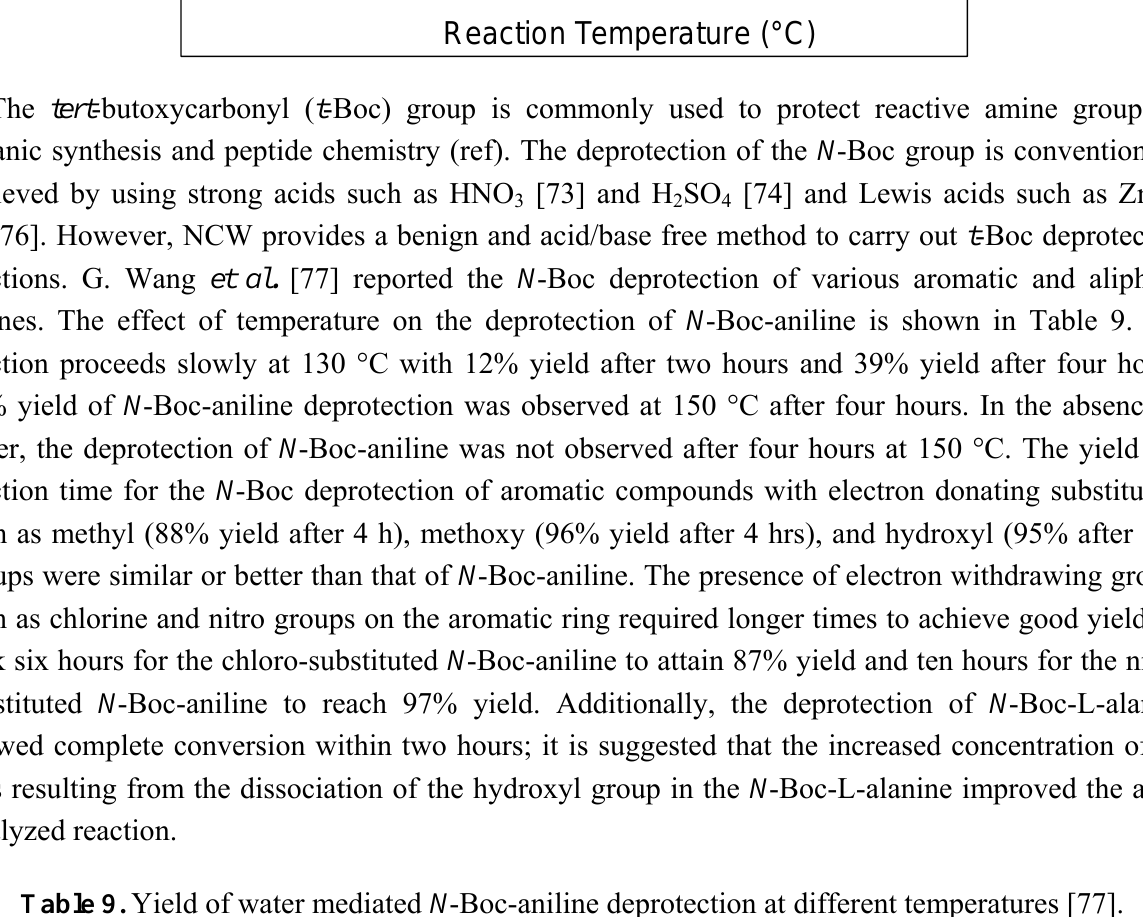
Table 9. Yield of water mediated N -Boc-aniline deprotection at different temperatures [77].